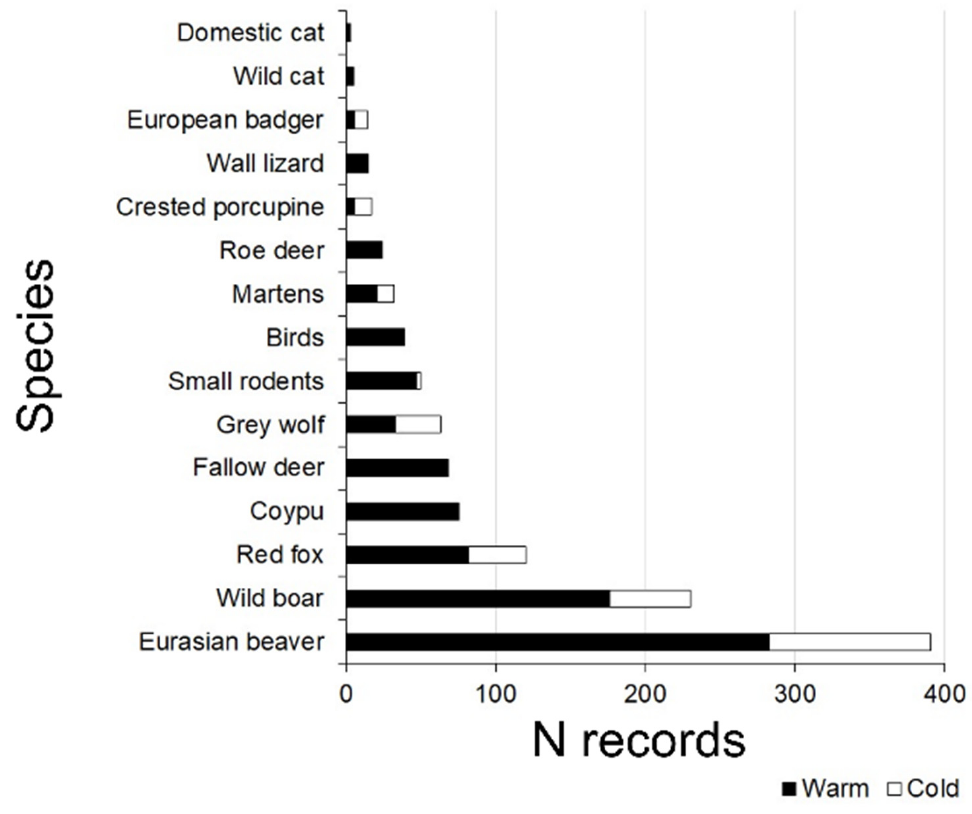
Figure 2. Number of independent video events per species and per season (cold and warm months; cf. Materials and Methods). Birds included 14 species: Anas platyrhynchos , Spatula clypeata , Gallinula chloropus , Fulica atra , Egretta garzetta , Ardea cinerea , Casmerodius albus , Botaurus stellaris , Phasianus colchicus , Streptopelia turtur, Erithacus rubecula , Turdus merula , Turdus philomelos , Corvus cornix , and Garrulus glandarius . Small mammals included 4 species: Apodemus spp., Chletrionomys glareolus , Arvicola italicus , and Rattus rattus . The least weasel is not included in this diagram, as it was camera-trapped only once.